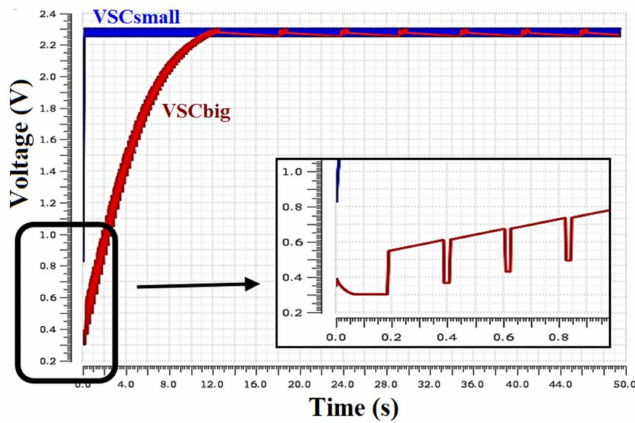
Figure 5. Supercapacitors charging mode and startup